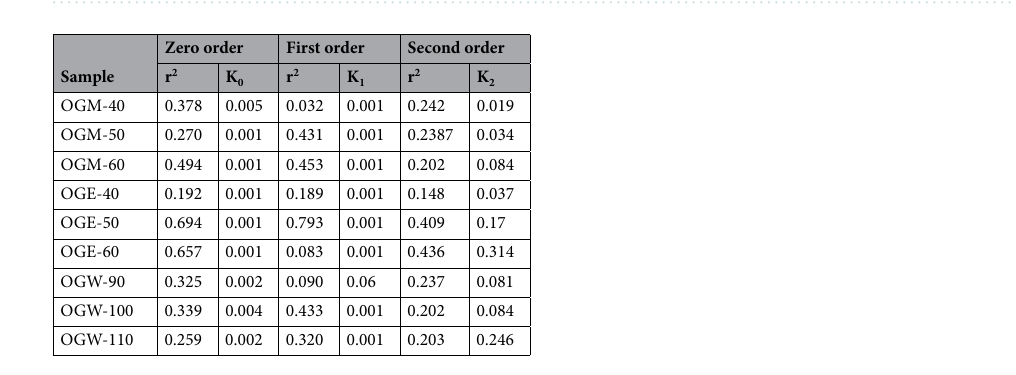
Figure 3. Arrhenius plots for the DPPH radical-scavenging activity of O. gratissimum extracts at different extraction temperatures as a function of exposure time. ( a ) Ethanolic extracts, ( b ) methanolic extracts, ( c ) water extracts. Bars represent mean ± standard deviation.